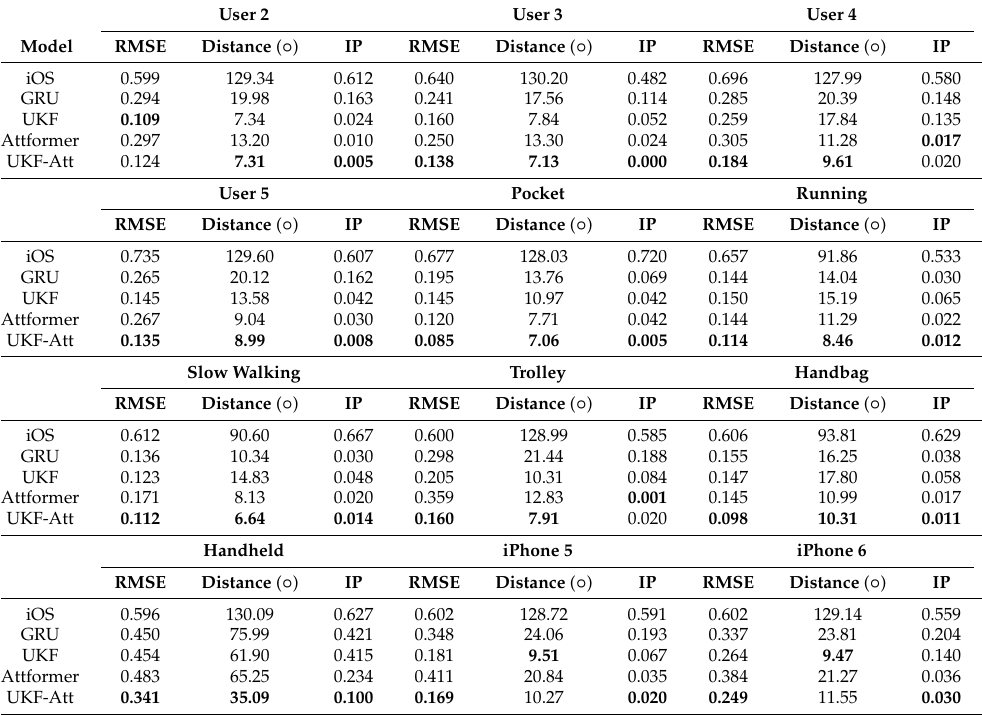
Table 1. Attitude error metric comparison over each full, unseen activity sequence. The best perform- ing approach over each sequence and for each metric has been made bold to aid the